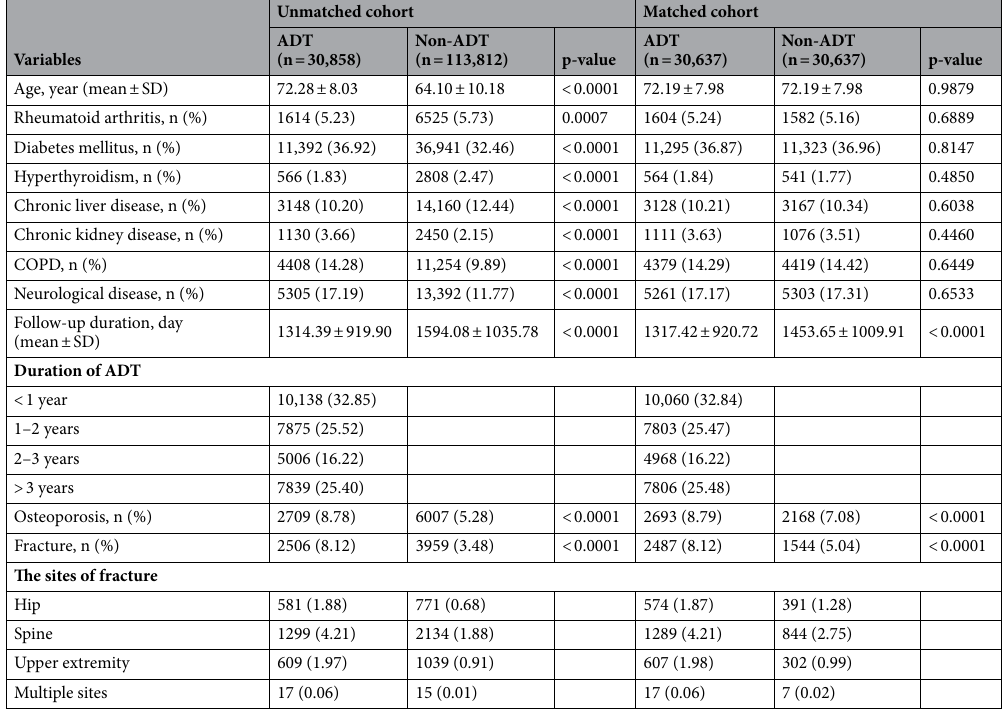
Table 1. Patient demographic characteristics. ADT androgen deprivation therapy, COPD chronic obstructive pulmonary disease, SD standard